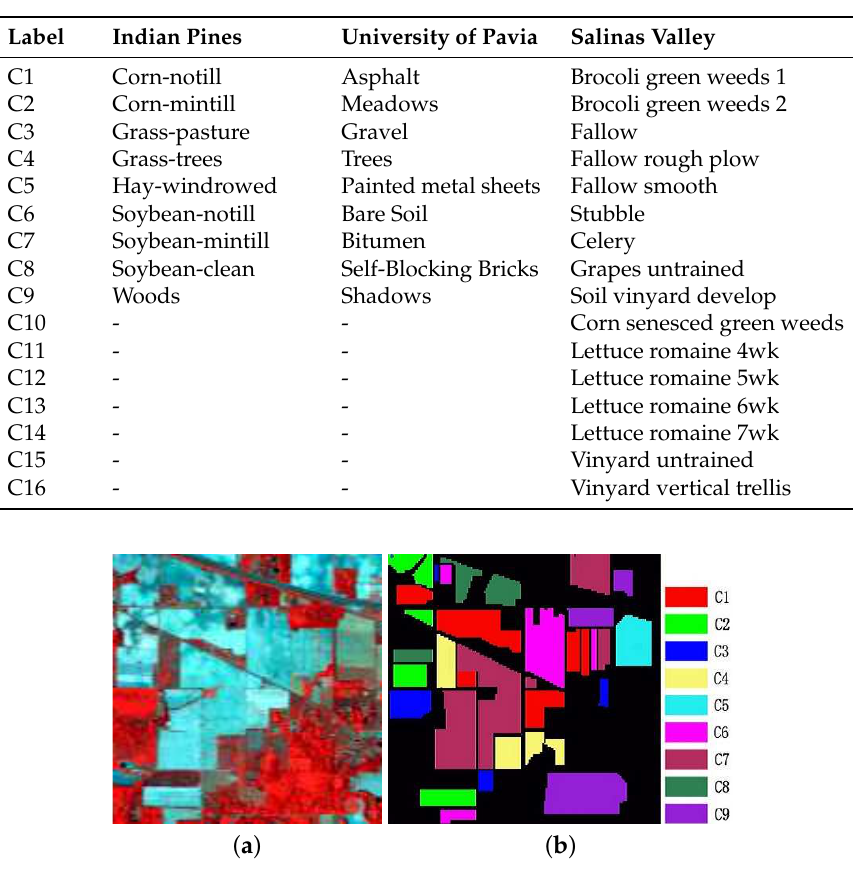
Table 1. Ground truth classes for the Indian Pines dataset and their corresponding numbers of samples.